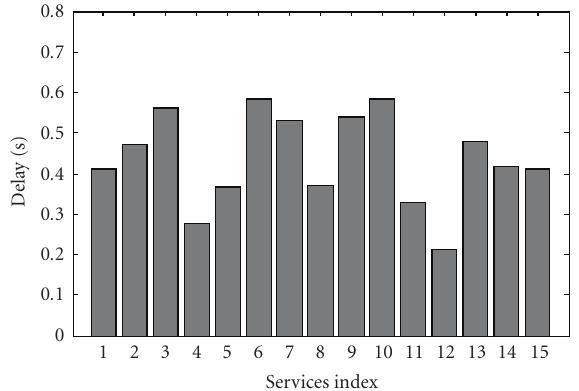
Figure 9: Bu ff ering delay for 15 multiplexed services in DetMux.